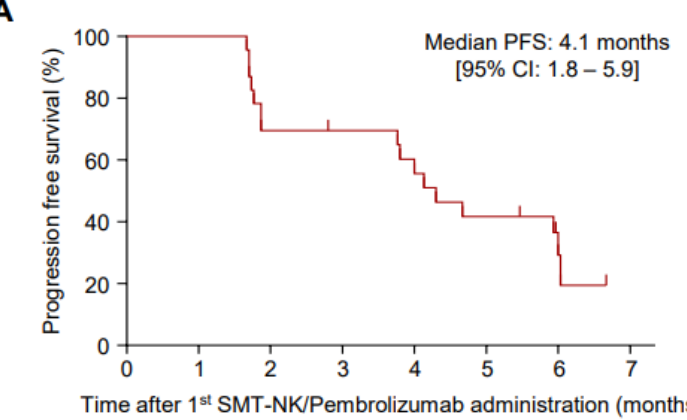
Figure 3. Cancer regression in two patients. CT images of the main tumor lesions at the baseline in each response evaluation. ( A – D ) Left infrarenal lymph node in patient E0107. ( E – H ) The main he- patic metastasis lesion in patient E0217. Yellow arrows indicate the target lesions. Response evalu- ations were performed after every three cycles.